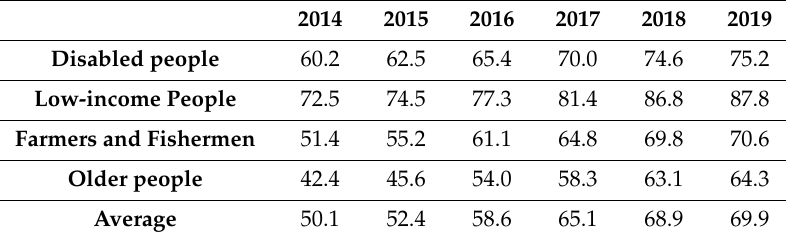
Table 5. Digital Divide Index of four groups.